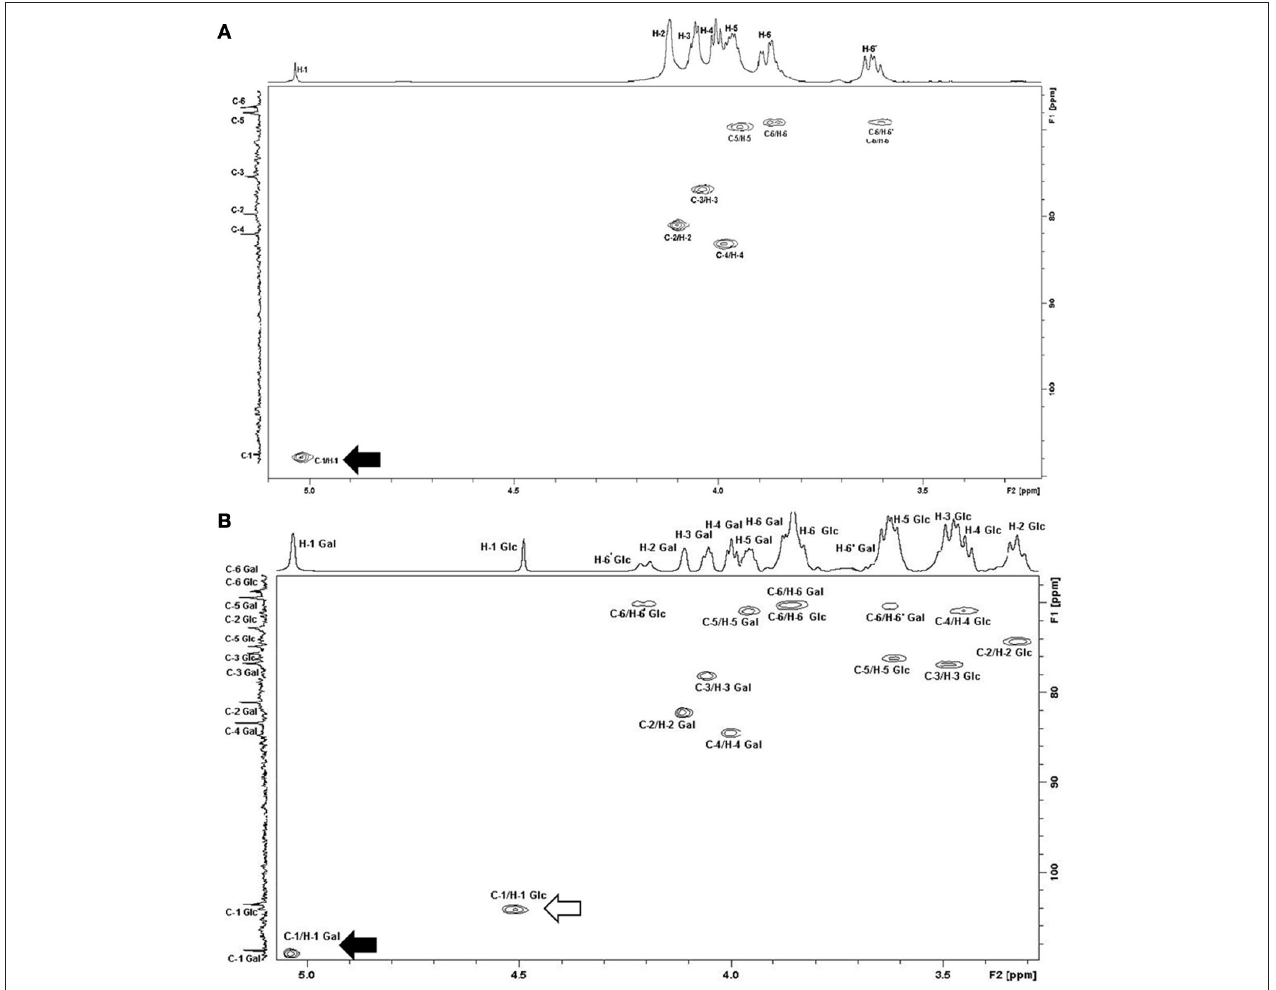
FIGURE 4 | 1 H/ 13 C HSQC NMR spectra of CPS from (A) M. feriruminatoris G5847 T ; (B) M . feriruminatoris 15568. The H-1 signal at 5 ppm and that of C-1 at 109 ppm were typical of D-galactose residues with β -furanoside configuration (black arrow). The chemical shift value obtained for C-6 indicated the presence of a linkage on the C-6 galactan residue. Thus, both strains G5847 T and 15568 are β -(1 → 6)-galactan producers. The H-1 signal at 4.5 ppm and that of C-1 at 104 ppm were typical of D-glucose residues with β -pyranoside configuration (white arrow). The H-6/C-6 ′ chemical values indicated the presence of a linkage on the C-6